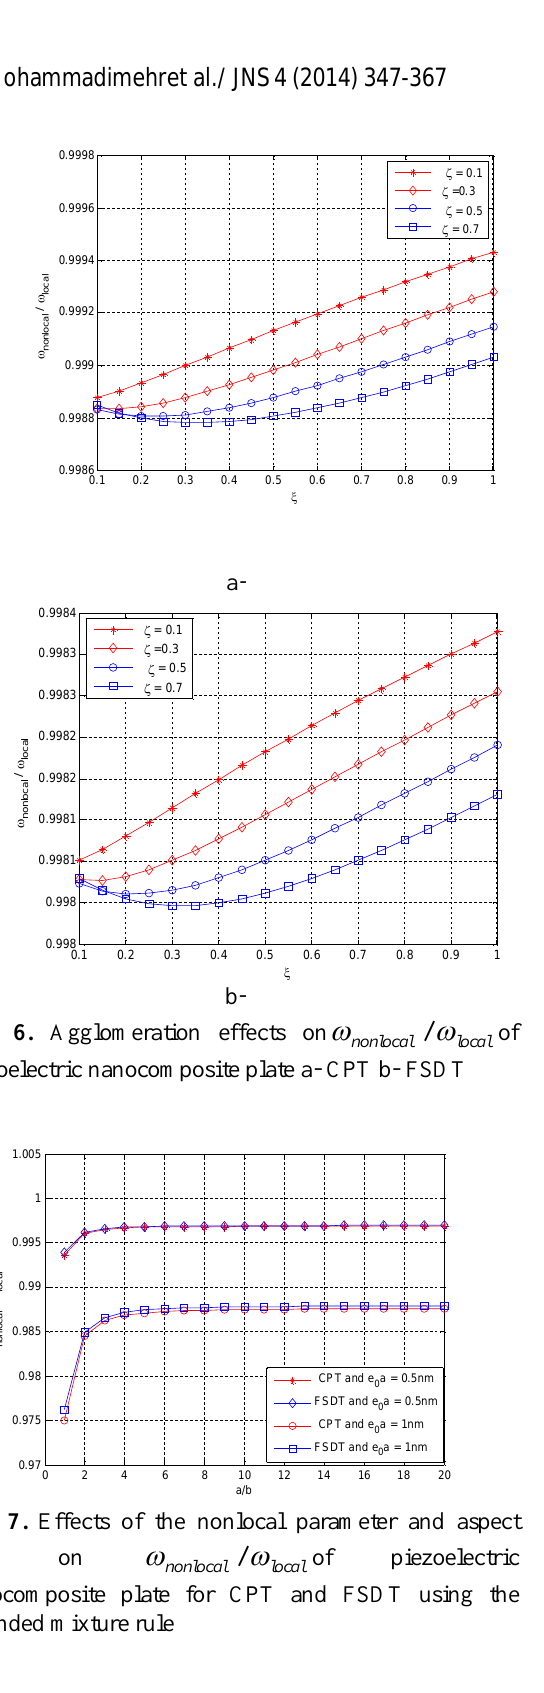
Fig. 7. Effects of the nonlocal parameter and aspect   of piezoelectric ratio on / nonlocal local nanocomposite plate for CPT and FSDT using the extended mixture